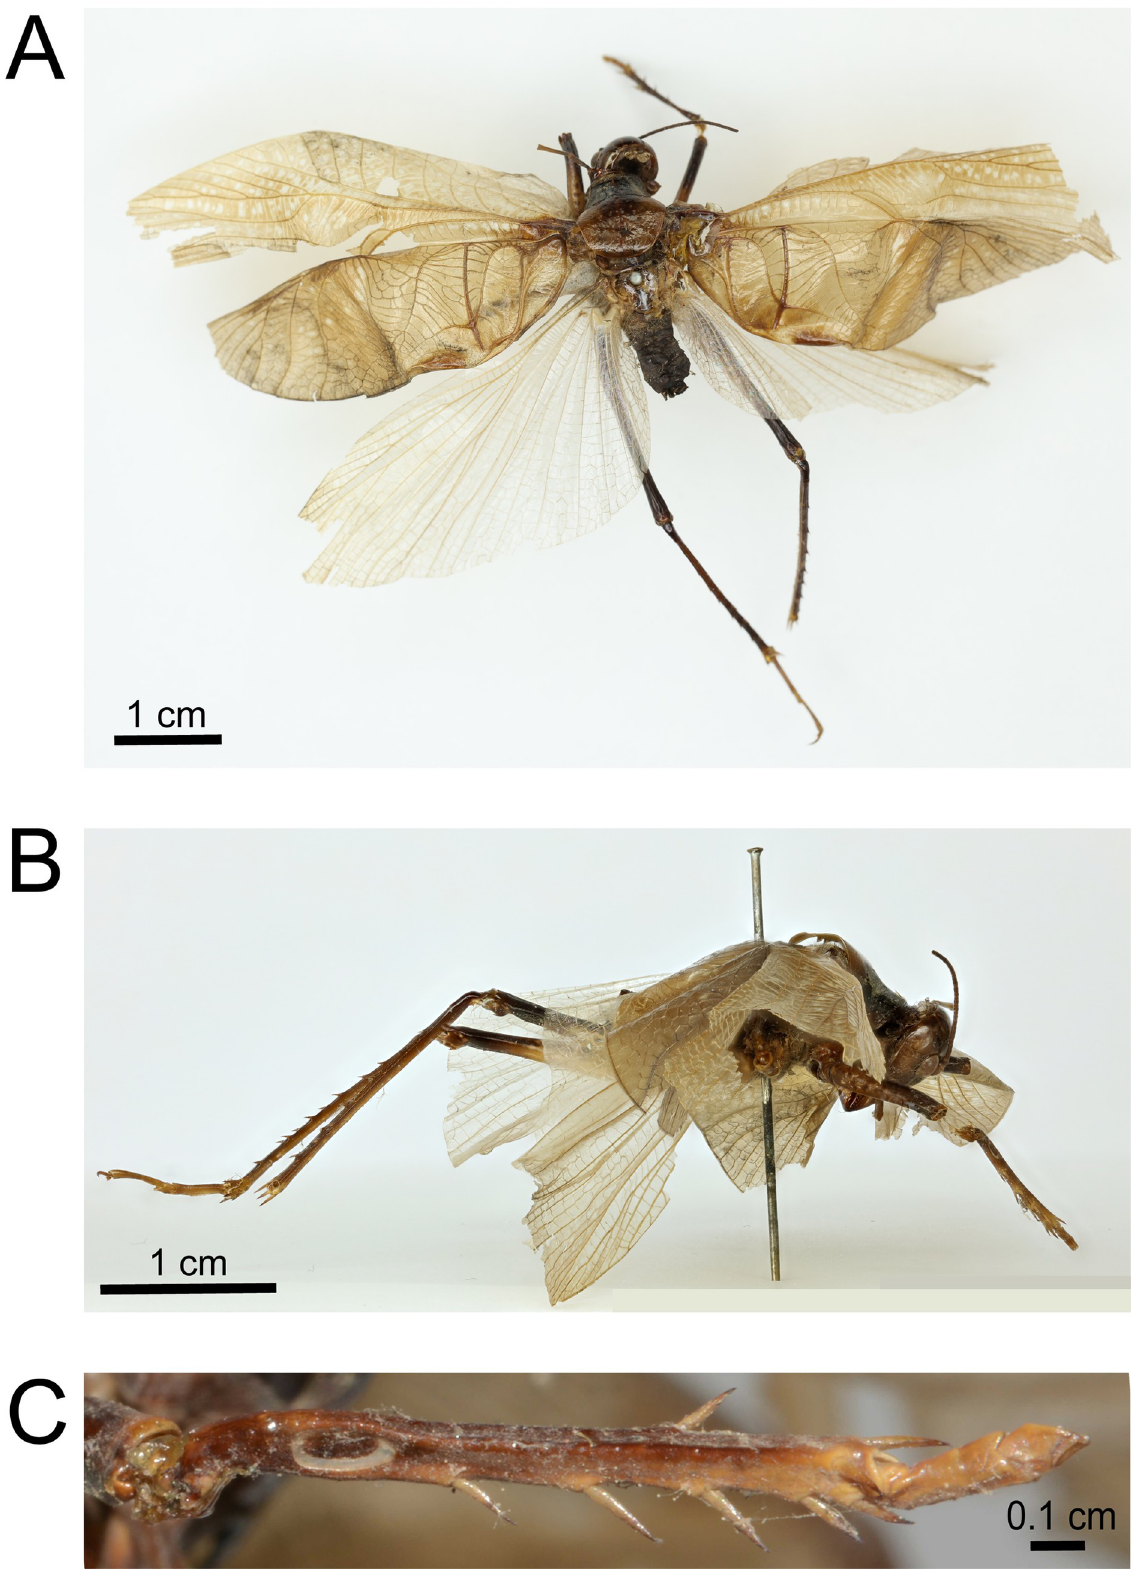
Fig 1. The holotype of Prophalangopsis obscura (collected in India, Walker 1869). A, dorsal habitus; B, lateral habitus; C, tympanal organ. https://doi.org/10.1371/journal.pone.0270498.g001 PLOS ONE | https://doi.org/10.1371/journal.pone.0270498 August 10,